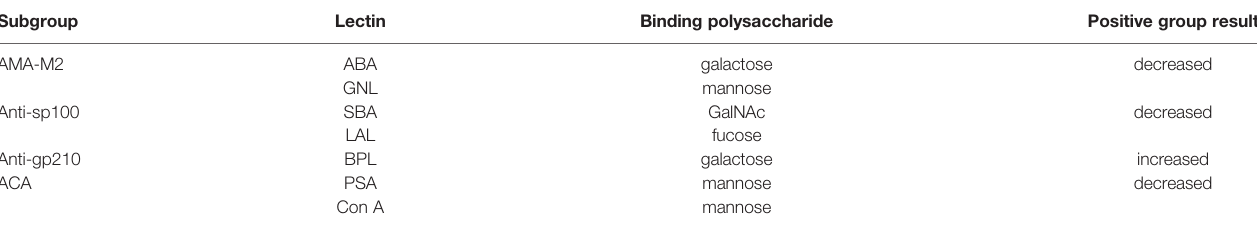
AMA-M2, antimitochondrial antibody M2; gp210, anti-glycoprotein-210 antibody; sp100, sp100 nuclear antigen; ACA, anti-centromere antibody; ABA, Agaricus bisporus lectin; GNL, Galanthus nivalis lectin; SBA, glycine max lectin; LAL, Laburnum anagyroides lectin; BPL, Bauhinia purpurea lectin; PSA, Pisum sativum agglutinin; ConA, concanavalin A lectin; GalNAc,